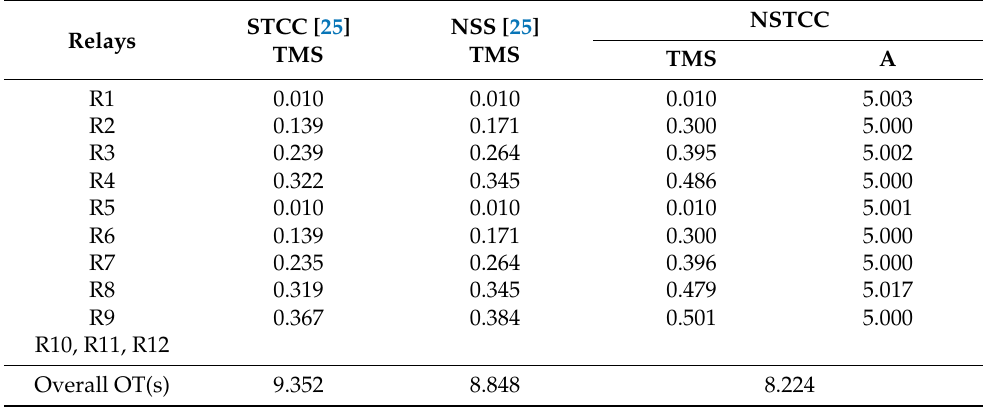
Table 3. The Overall OT for STCC, NSS, and NSTCC Curves in IEEE 9-Bus (DGs- Mode 1).